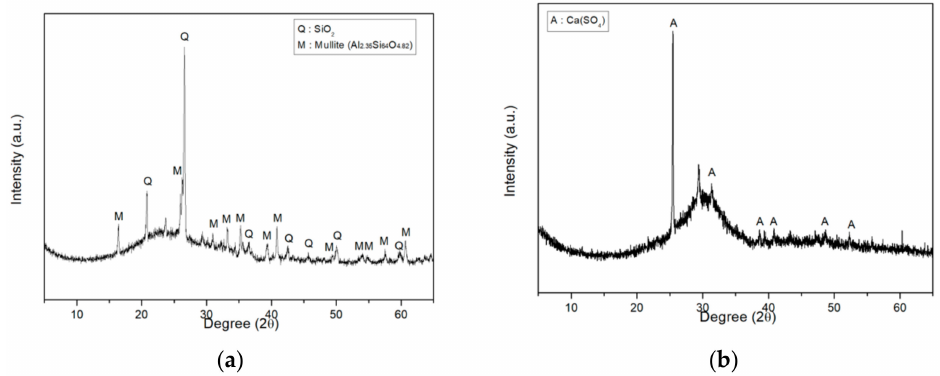
Figure 2. XRD spectra of the amorphous fillers: ( a ) Fly ash; ( b ) Blast furnace slag.